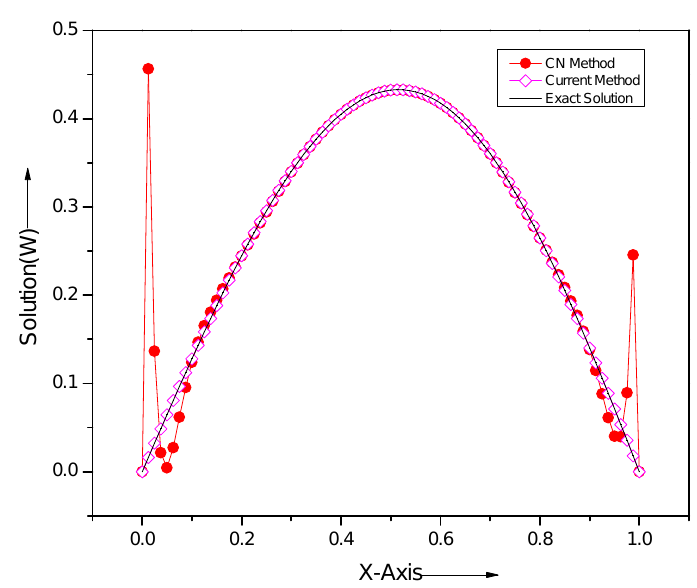
Figure 14. Comparison of analytical solutions and numerical solutions by our method and CN method for the problem 5.6 at T = 0.1 for ∆ x = 0.0125, ν d = 2, and τ =